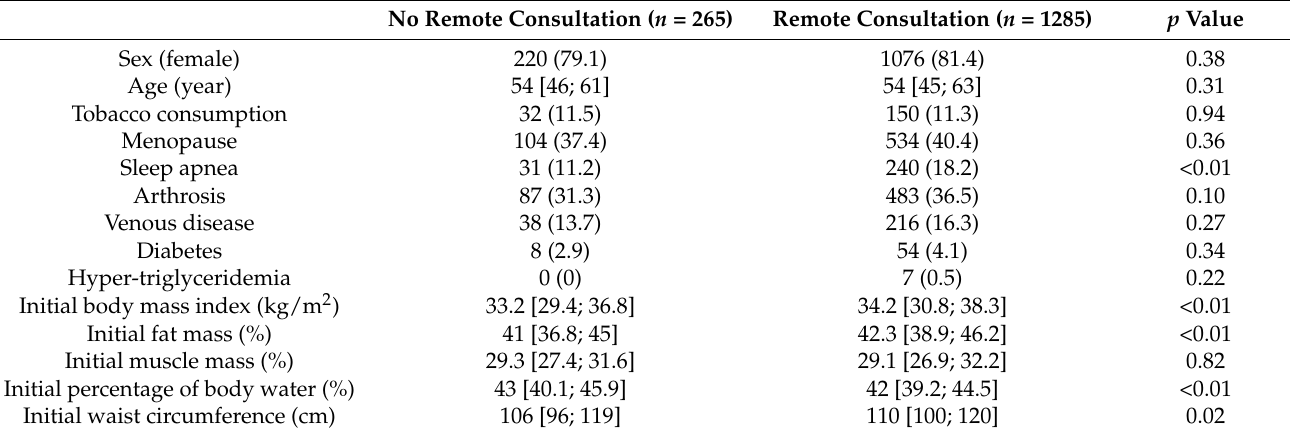
Table 2. Subject Table 2. Subject characteristics.